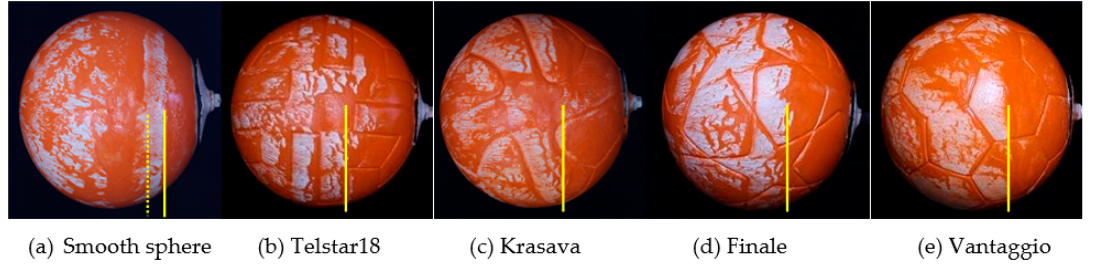
Figure 4. The results of the oil film experiment to grasp the separation point on the panels. Table 2. The PIV Results of the Evopower with different panel orientations and different flow aspects. No.